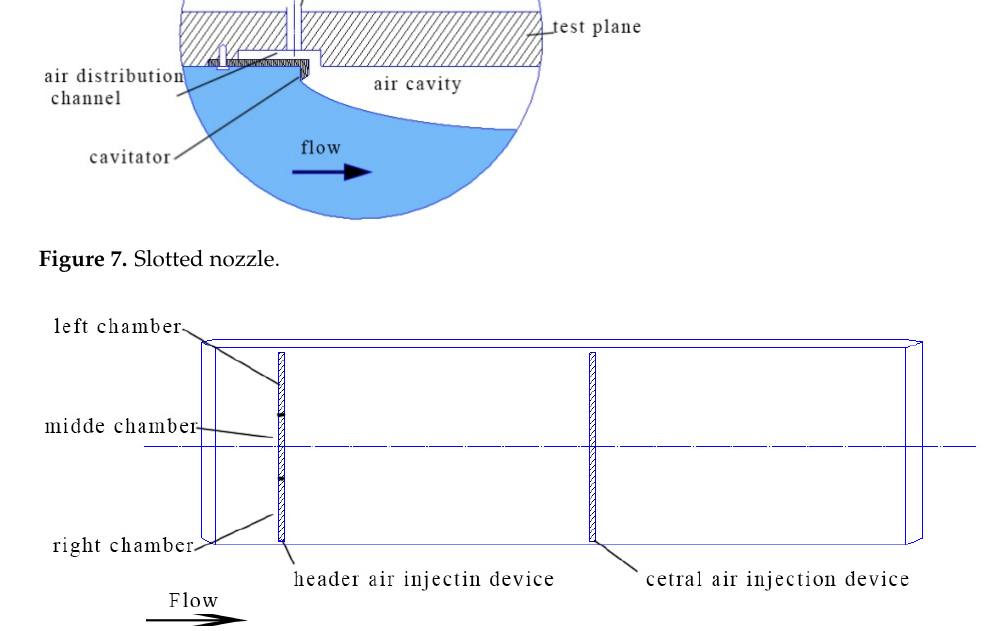
Figure 8. Chamber type of the jet hole.